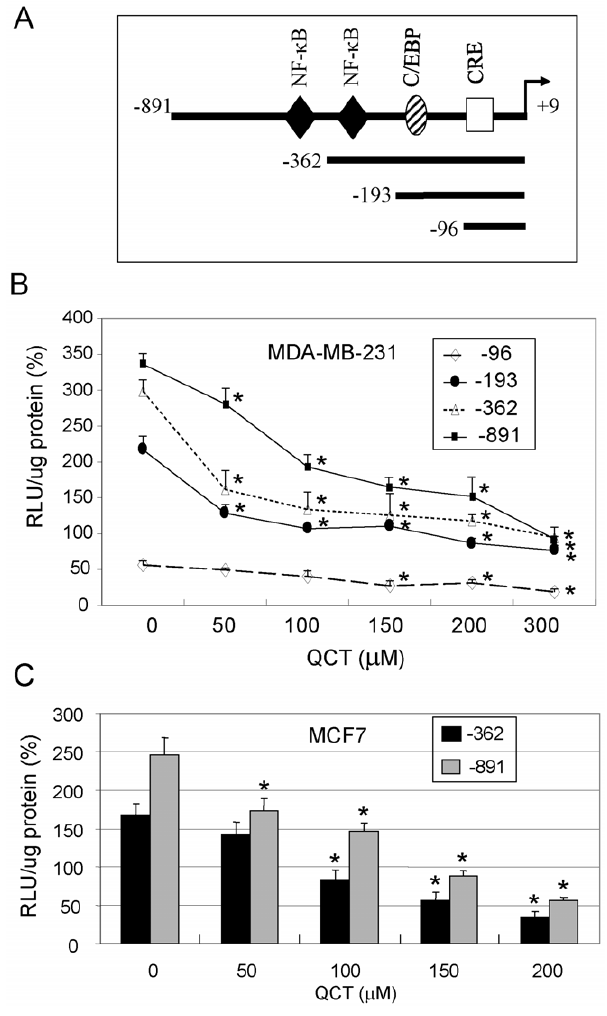
Figure 2. Quercetin inhibited COX-2 promoter activity. MDA- MB-231 and MCF7 cells were transfected with a luciferase expression vector containing a 900-bp wild-type COX-2 promoter or its 5-deletion mutants ( A ), and then treated with quercetin for 24 h. Luciferase activity was measured using a luminometer and the results were expressed as relative light unit (RLU) ( B , C ). Numbers shown for each promoter construct correspond to the COX-2 promoter sequence. Each bar denotes mean 6 SD of three experiments. *, P , 0.05, significant differences between treatment groups and control groups.